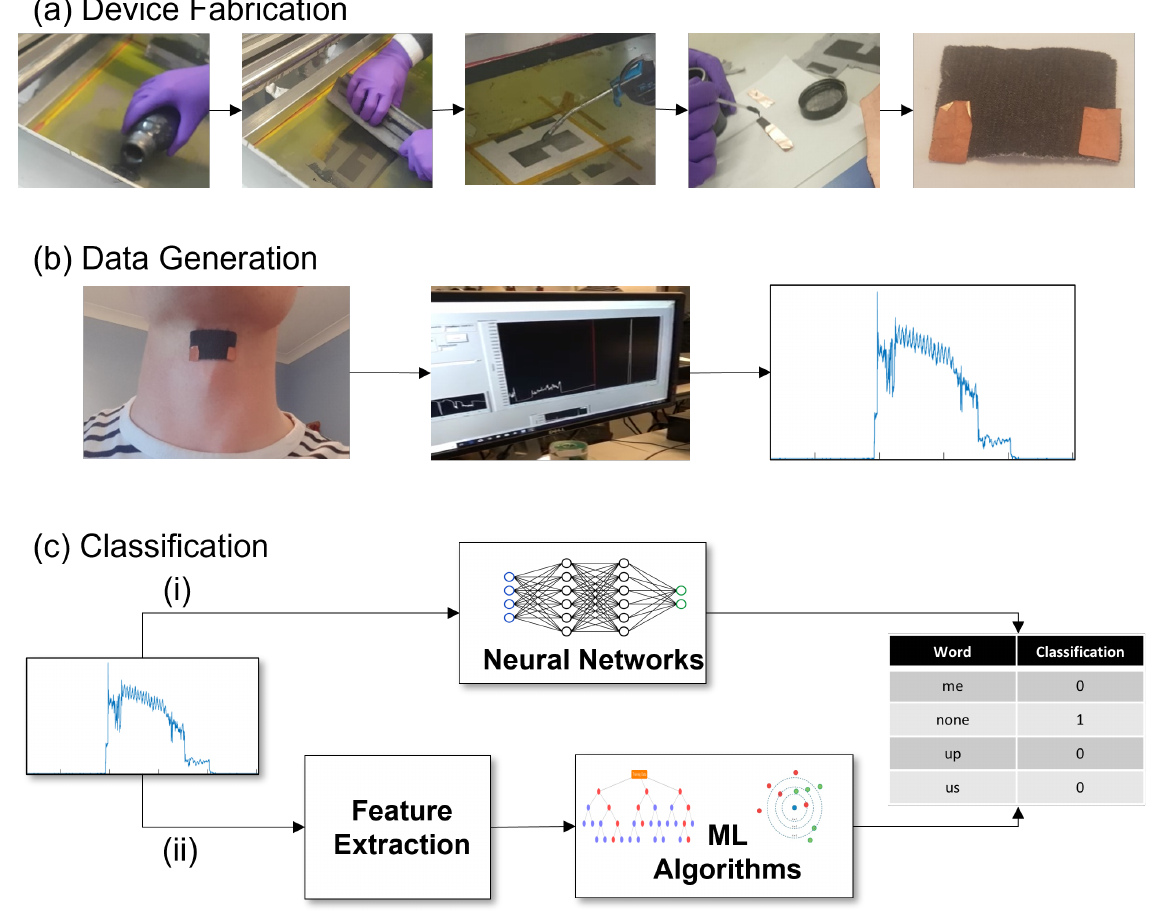
Figure 1. Flowchart of the proposed method. ( a ) Device Fabrication—Graphene ink is screen printed onto lycra fabric ensuring a full coverage. The device is cut to size and electrodes area attached using silver paste. ( b ) Data Generation—The strain gauge sensor is worn on the user’s throat of the subject. The electrodes area attached to an ohmmeter to make resistance recordings across the device. ( c ) Classification—The data are labelled and split into training and testing sets. For classification either, ( i ) The raw signal data is passed to a convolutional-recurrent artificial neural network, as shown in Figure 2, which learns the pertinent features during its training phase and makes predictions on unseen test data, or ( ii ) Handcrafted features are extracted and random forests or k-nearest neighbour classifiers are used for the training and testing of the